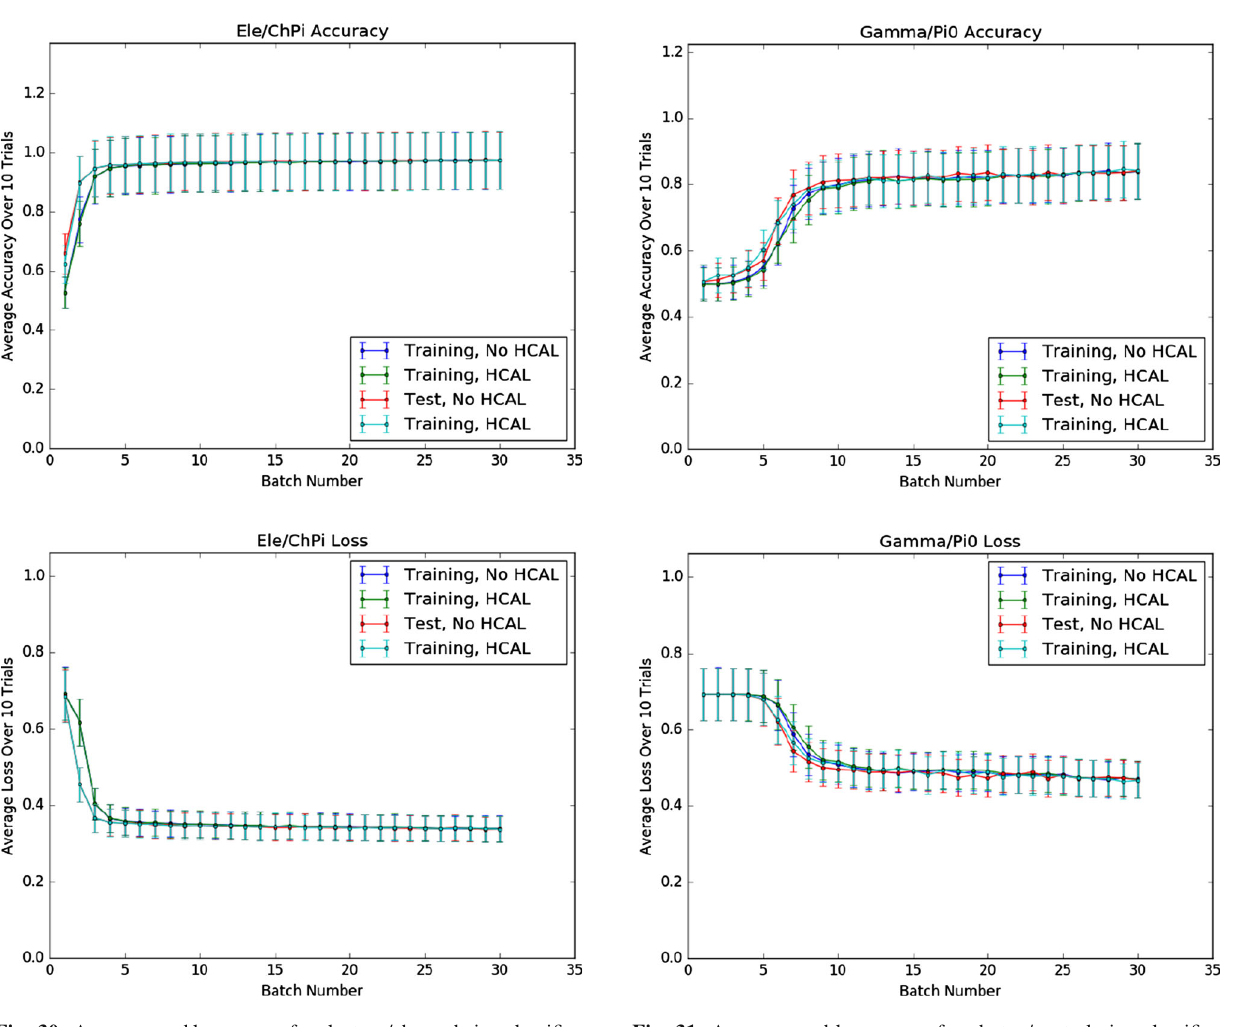
and ten training sessions without HCAL. Averaged training